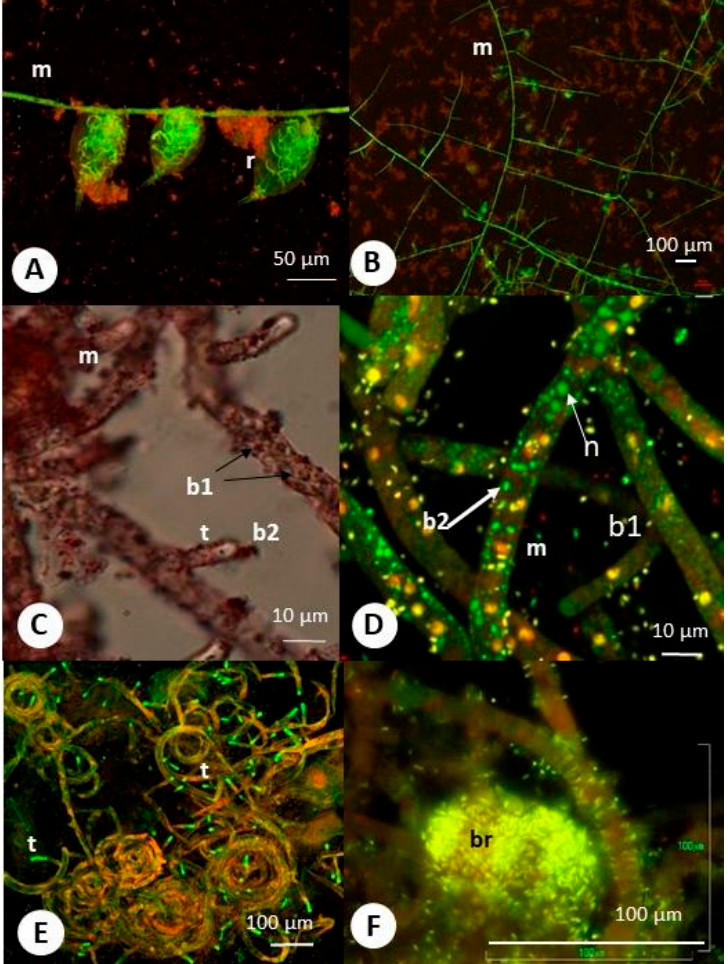
Figure 1. Predatory fungus ( Zoophagus insidians ), rotifers ( Lecane inermis ), and bacteria cultured in “ Ż ywiec” water. ( A ) Rotifers trapped by fungus with absorptive hyphae developed within rotifer; ( B ) mycelium forming network on the surface of the glass; ( C ) mycelium with lipids stained with oil red O; ( D ) mycelium with traps and abundant bacteria; ( E ) coiled mycelia with numerous traps (green); ( F ) dead rotifer with bacteria inside; ( A , B ) and ( D , E , F ) material stained with Live–Dead Bacterial Kit; m—mycelium; c—mycelial coil; t—green stained traps; n—nucleus; b1—bacteria inside mycelium; b2—bacteria outside mycelium; br—bacteria within rotifer; r—rotifer; t—trap.